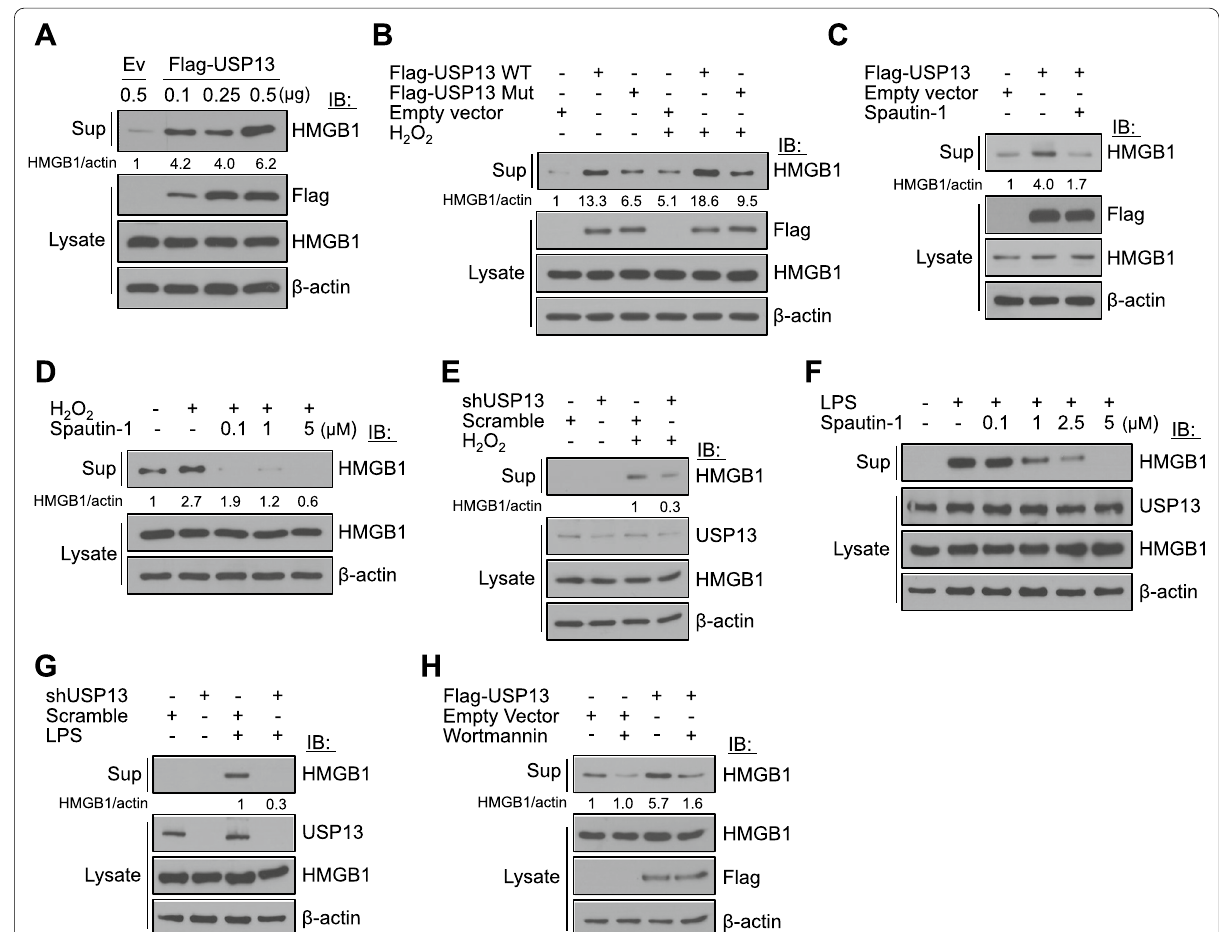
Fig. 6 USP13 promotes HMGB1 secretion. A HEK293T cells were transfected with Flag‑USP13 plasmid for 48 h. Culture supernatants were harvested and immunoblotted with anti‑HMGB1 antibody. B HEK293T cells were overexpressed with USP13 wildtype (WT) or USP13C345A/M664/739E (Mut) plasmid for 48 h and treated with 50 μM H 2 O 2 for the last 18 h. N 3. C HEK293T cells were transfected with Flag‑USP13 plasmid for 48 h and then = treated with 10 μM Spautin‑1 for the last 18 h. D HEK293T cells were pre‑treated with 0.1, 1, 5 μM Spautin‑1 for 1 h, and 50 μM H 2 O 2 was treated for 18 h. E HEK293T cells were transfected with shRNA USP13 plasmid for 48 h and treated with 50 μM H 2 O 2 for the last 18 h. F RAW 264.7 cells were pre‑treated with 10 μM Spautin‑1 for 1 h and then with 100 ng/mL LPS for 18 h. G Stably expressed HEK293/hTLR4‑MD2‑CD14 cells were transfected with shRNA USP13 plasmid for 48 h and treated with 100 ng/mL LPS for the last 18 h. H HEK293T cells were transfected with Flag‑USP13 plasmid for 48 h and then treated with 80 nM Wortmannin for the last 24 h. All data represent one of two ( A , G , and H ) or three ( B – D ) similar independent